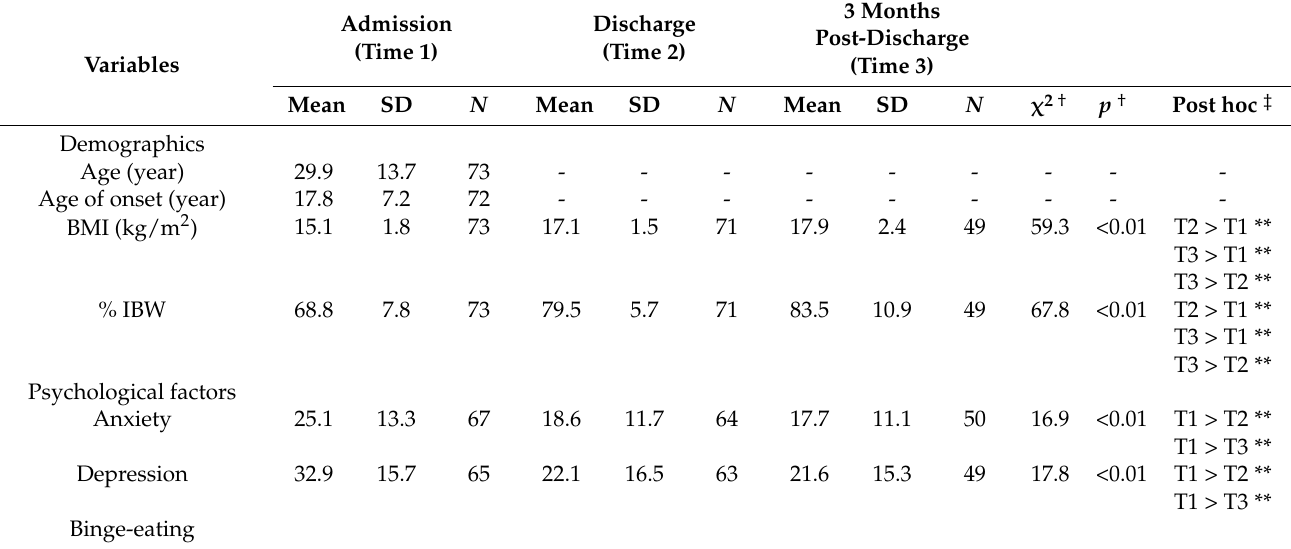
Table 1. Demographic, clinical, and hormone variables for admission, discharge, and 3 months